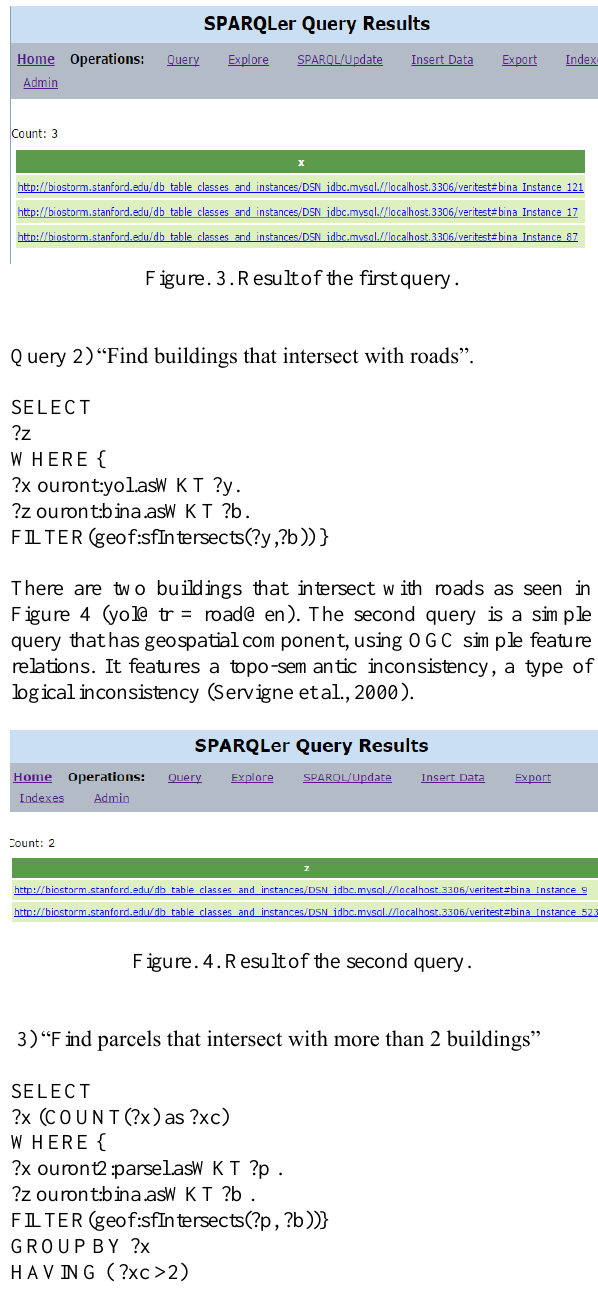
Figure.2. Protégé ontology editor with the ontology